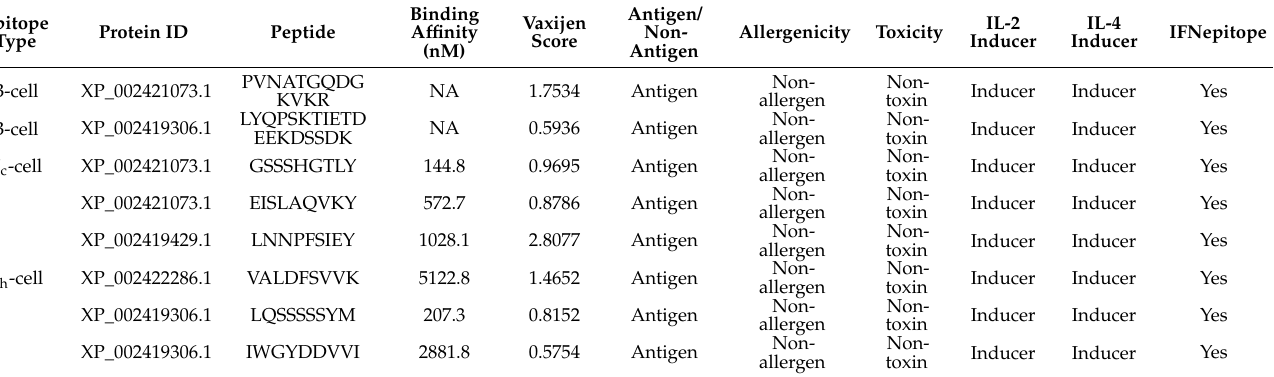
Table 2. Final epitopes selected for vaccine design and their